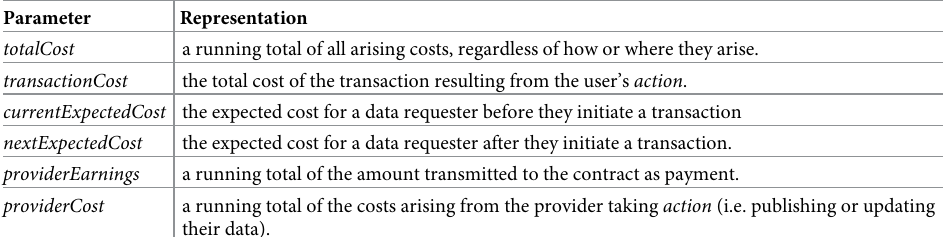
Table 2. Cost parameters used in the incentive model.